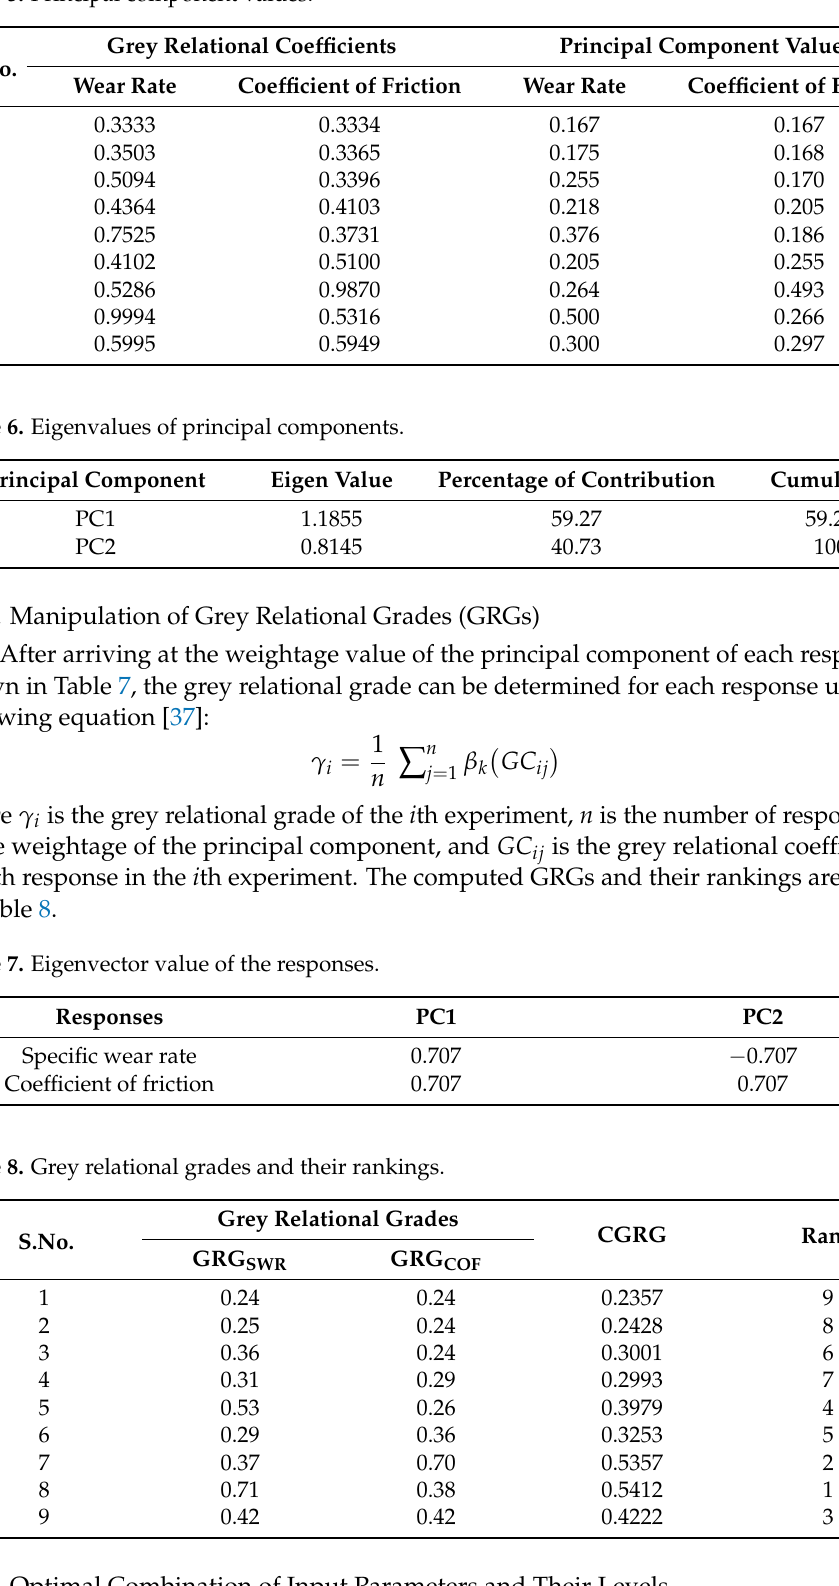
Table 5. Principal component values.